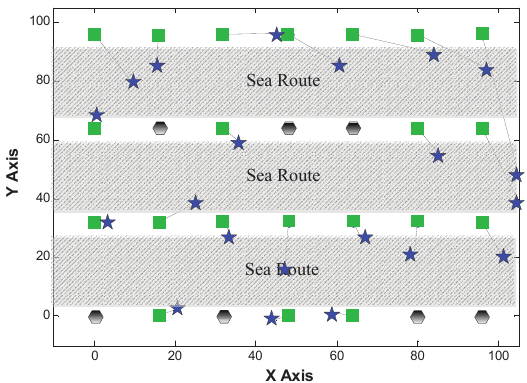
Figure 8. Localization results of MDS-SSLE.